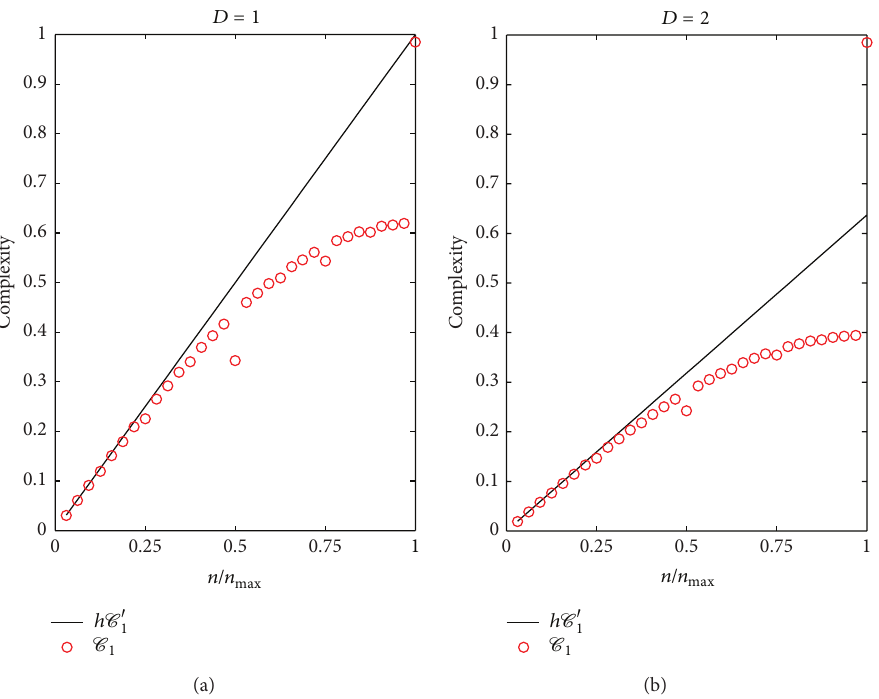
Figure 1: A comparison of the continuous and discrete versions of the first-order term generalization complexities for the 𝐷 = 1 and 𝐷 = 2 set of functions from (15) using 𝑁 = 100 . The discrete GC 𝐶 1 is computed over a grid with spacing ℎ and so the continuous input complexity ℎ . 𝐶 󸀠 1 is plotted multiplied by